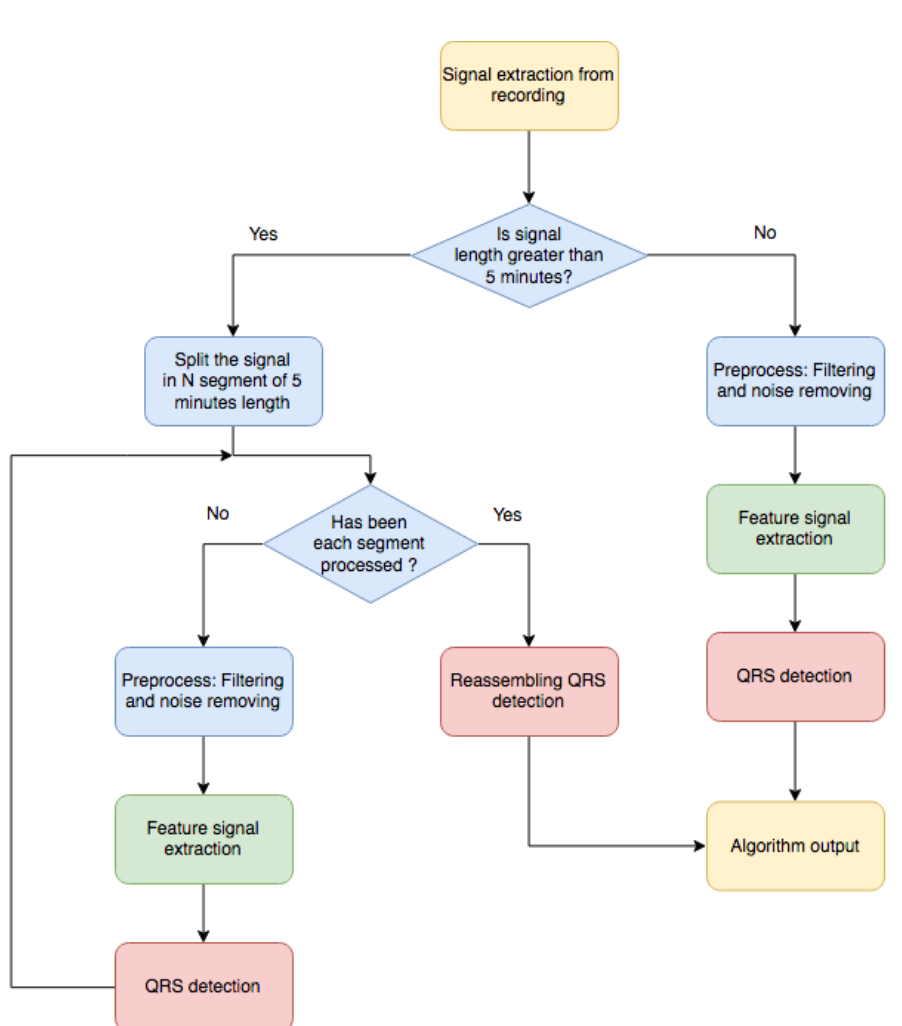
Figure 1. Main stages of the QRS detection algorithms proposed in this work. The yellow boxes are inputs/outputs, the blue boxes represent the preprocessing stage, the green boxes represent the feature signal extraction stage, and the red boxes represent the QRS detection